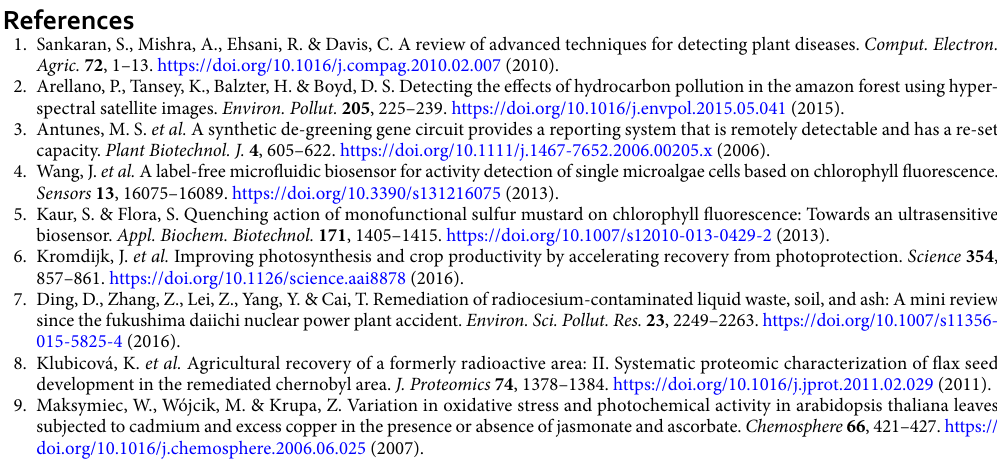
control and uranium-exposed samples. The samples were stored in glass flasks, sealed with parafilm, and agitated twice for 1 minute each over a 24-hour period. Steady‑state absorption and filament‑induced fluorescence. Steady-state absorption spectra were recorded with a Varian Cary 50 UV-VIS-NIR spectrophotometer, with a spectral range of 190–1100 nm. Meas- urements were made 1 hour and 24 hours after stress exposure. The experimental schematic for F-IF is shown in Fig. 8. A Ti:sapphire chirped-pulse amplification system was used, operating at a central wavelength of 790 nm, 480 Hz, 50-fs pulse duration, and an output energy of up to 18 mJ. A half-wave plate was used to control the power of 395-nm light generated after passing through a 200- µ m-thick Type I β -Ba(BO 2 ) 2 crystal for SHG. A dichroic mirror was used to reject any residual 790-nm light, and the final energy after SHG was ∼ 80 µ J. This resulted in a peak power of 1.6 GW, and the critical power for self-focusing at ∼ 395 nm of ∼ 0.3 GW; therefore we have not entered the multiple filament regime which generally requires (cid:31) 10 × P cr 55 . The Gaussian beam diameter was 22 mm, and we seeded the filamentation process with a 75-cm-focal length lens ( f /30). We placed a 1-cm path length quartz cuvette (Thorlabs, CV10Q35FA) containing the algae samples approximately 50 cm after the termination of filament, resulting in a total excitation distance from the focusing lens of 1.25 m. The filament formed approximately 1 cm prior to geometric focus, and the plasma channel length was ∼ 3 cm as estimated from its optical emission. The F-IF was collected transverse to to the laser propagation direction with an electron multiplying-ICCD (EM-ICCD, PI-MAX4 Princeton Instruments) coupled to a variable telescopic lens. Two filters were used to isolate the main chlorophyll fluorescence bands, one with a central wavelength of 675 nm and a 20-nm-FWHM and another with a central wavelength of 720 nm and a 10-nm-FWHM (Andover). Time- integrated and time-resolved fluorescence measurements were recorded after 24 hours of sample preparation.